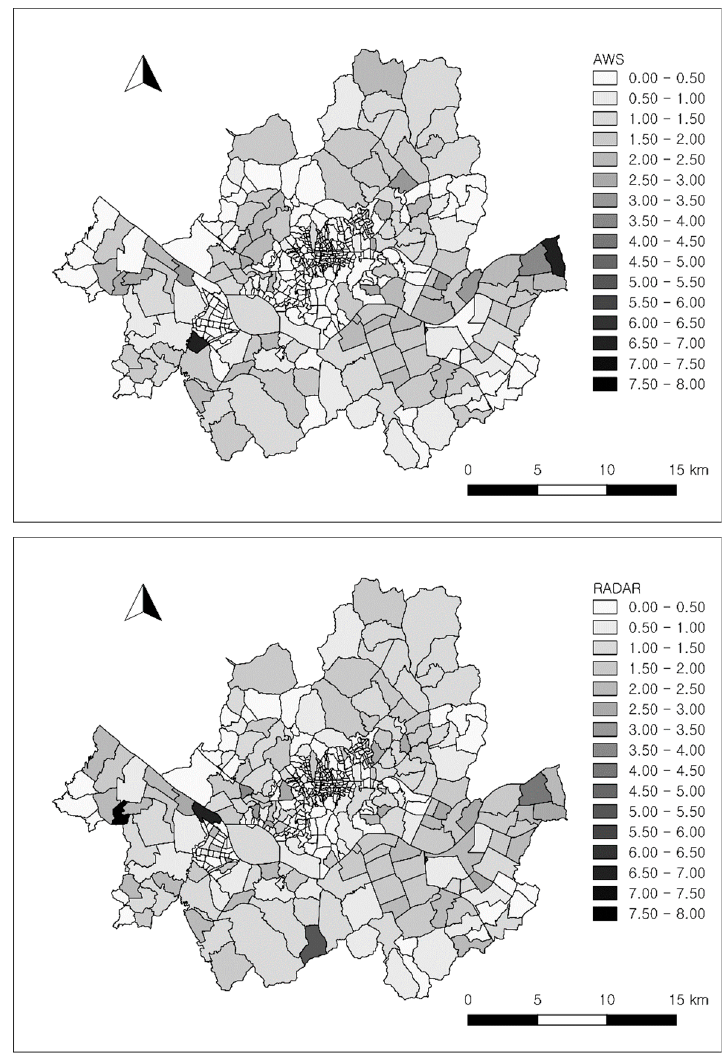
Figure 10. District-wise RAR distribution based on interpolated AWS rainfall (upper) and from